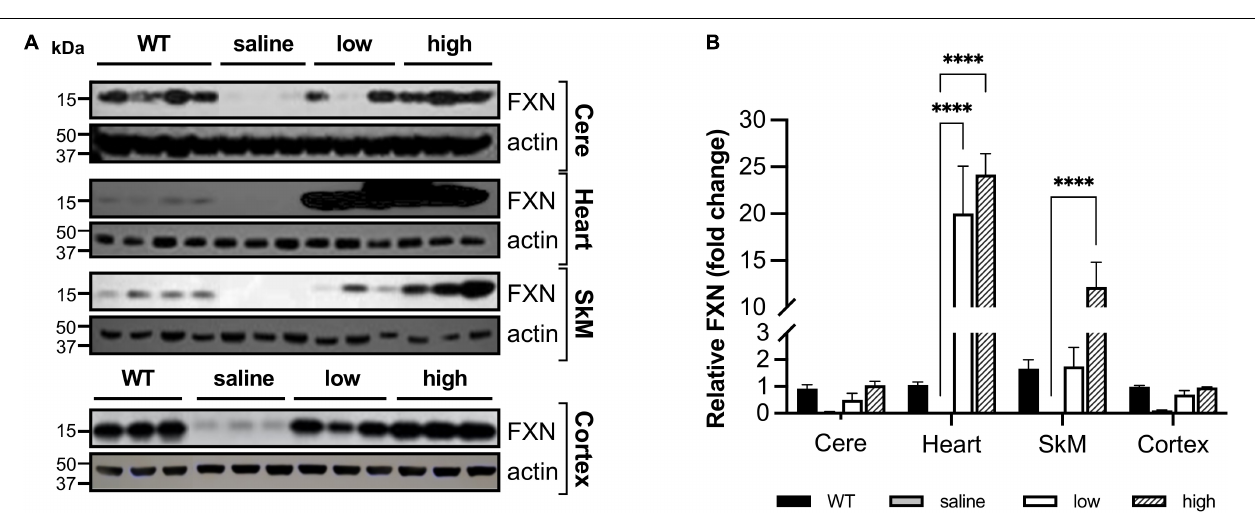
FIGURE 10 | AAV8-m FXN gene therapy partially restores frataxin in peripheral and central nervous system tissues of FRDAkd mice (A) western blot analysis and (B) quantification of frataxin normalized to loading control (actin) in the cerebellum (Cere), heart, skeletal muscle (SkM), and cortex of wild-type (WT) mice, and transgenic (dox treated) mice treated with AAV8 low or high dose (Stats: WT = combined results for WT + and WT-, n = 4, TG + saline, n = 3, TG + low, n = 3, TG + high, n = 3, mean ± SEM, two-way ANOVA with Tukey’s post hoc , ns = not significant, ∗∗∗∗ P < 0.0001, stats displayed are comparing saline to low and high dose AAV8 treated